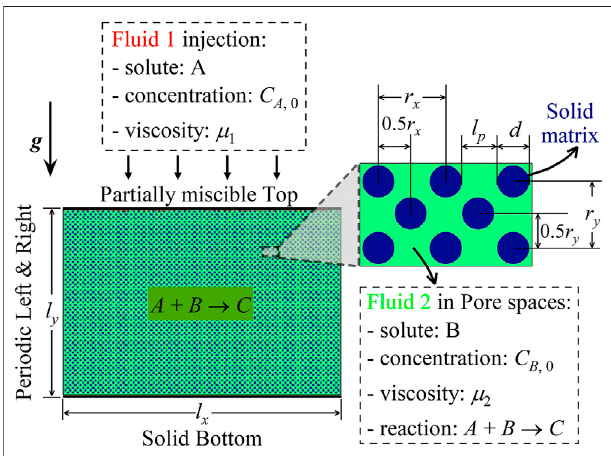
FIGURE2| Schematicoftheproblem:density fi ngeringwiththereaction A + B → C in porous media.